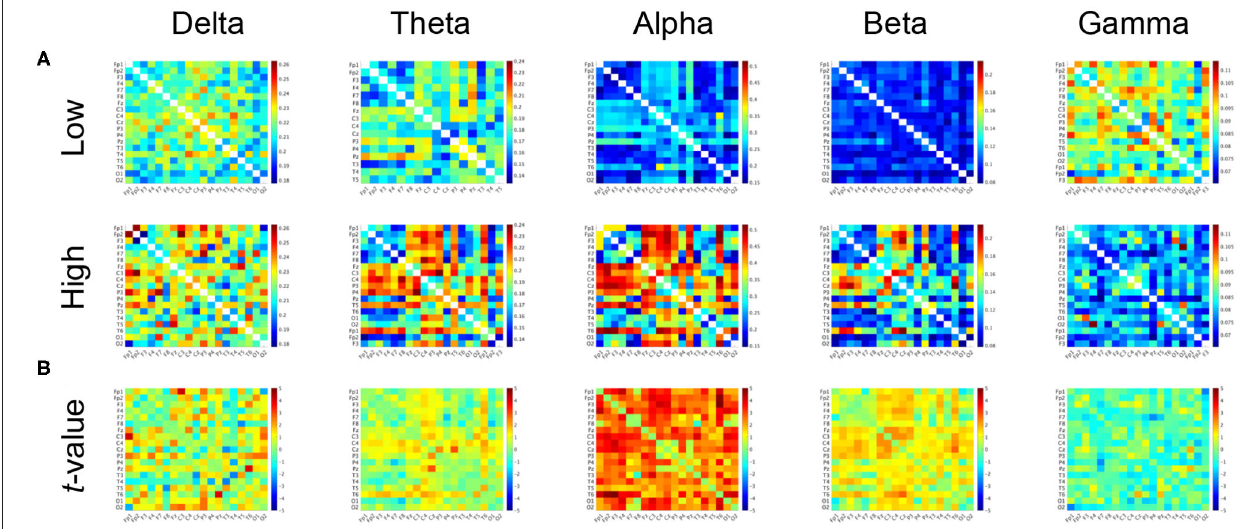
FIGURE 2 | (A) Mean values of PLI in the low-creativity group (upper) and high-creativity group (lower). (B) t -values of the group-wise comparisons. Warm (cool) color indicates PLI values of the high-creativity group greater (less) than those of the low-creativity group. No significant differences after adjustment for FDR with q < 0.05 were